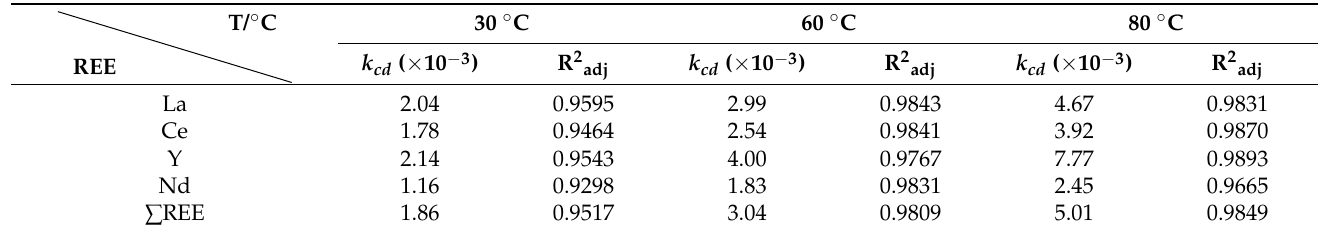
Table 5. k cd and R 2 adj for the SCM of diffusion control based on cylindrical particles.